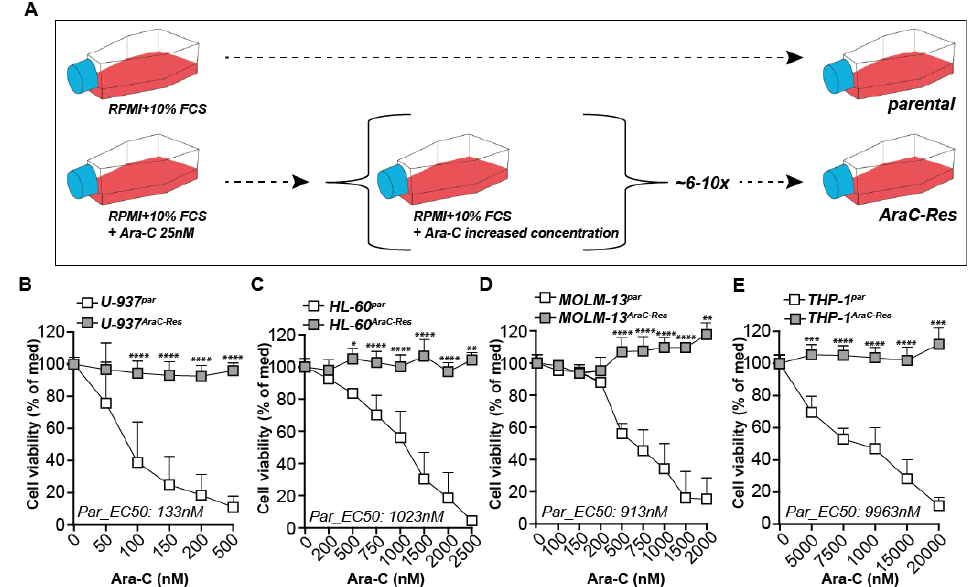
Figure 1. Generation of cytarabine resistant cell lines. ( A ) Acute myeloid leukemia (AML) cell lines stably resistant to cytarabine (AraC-Res) were generated by culturing AML cell lines under gradually increasing doses of AraC for up to a year (~6–10 times increase in AraC dose). ( B – E ) Cell viability of all cell line pairs upon treatment with a dose range of AraC as measured by MTS assays after 72 h of incubation (at least n = 5). Significance was tested using students’ t -test. p values are indicated as: **** p < 0.0001, *** p < 0.001, ** p < 0.01, and * p < 0.05.